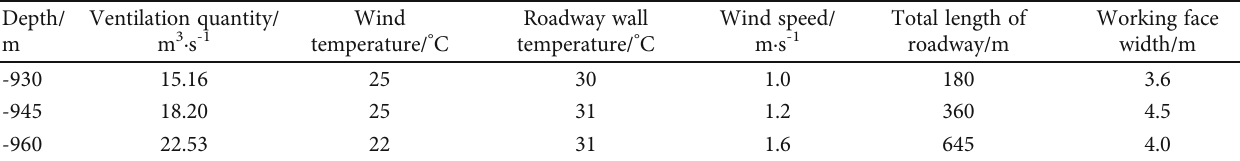
Figure 1: Schematic diagram of heat source system in deep mine stope. Table 1: Parameters of heading face.